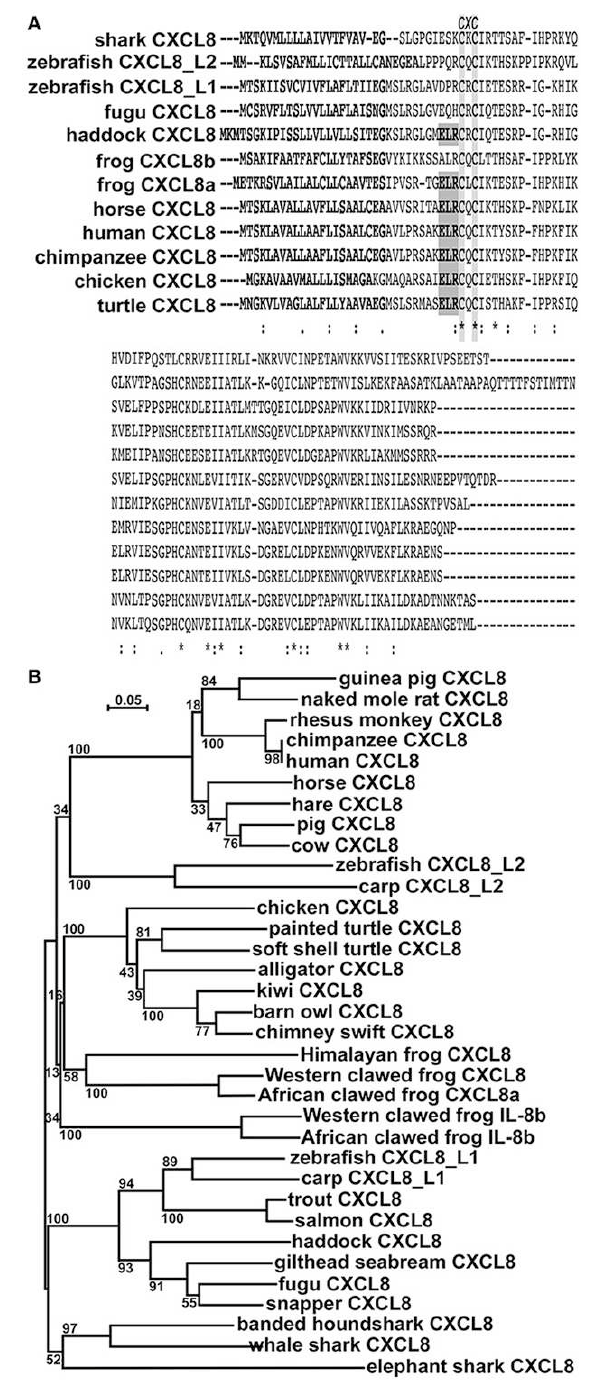
FIGURE 1 | In silico analyses of CXCL8 phylogeny and protein sequence conservation. (A) The protein alignment was performed using ClustalW2 server. Fully conserved residues are indicated by an asterisk (*), partially conserved and semi-conserved substitutions are represented by “:” and “.”, respectively. Putative signal peptides are bolded, the ELR motif is boxed in gray and the conserved CXC motif is highlighted. (B) The phylogenetic tree was